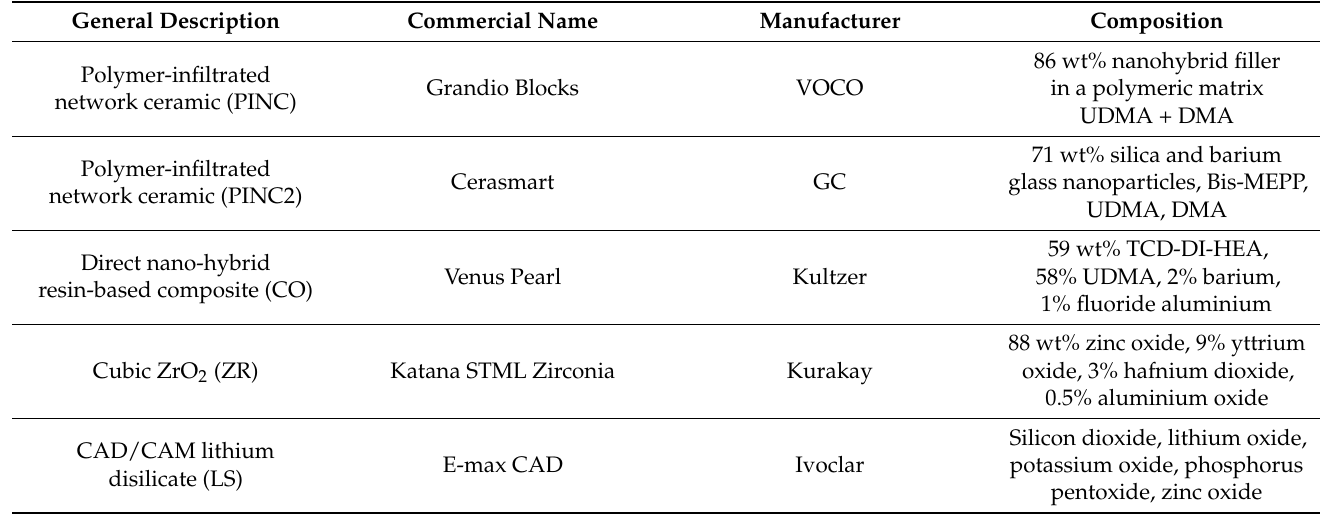
Table 1. General description of the main materials used in the present study, along with their commercial name, manufacturer and composition.